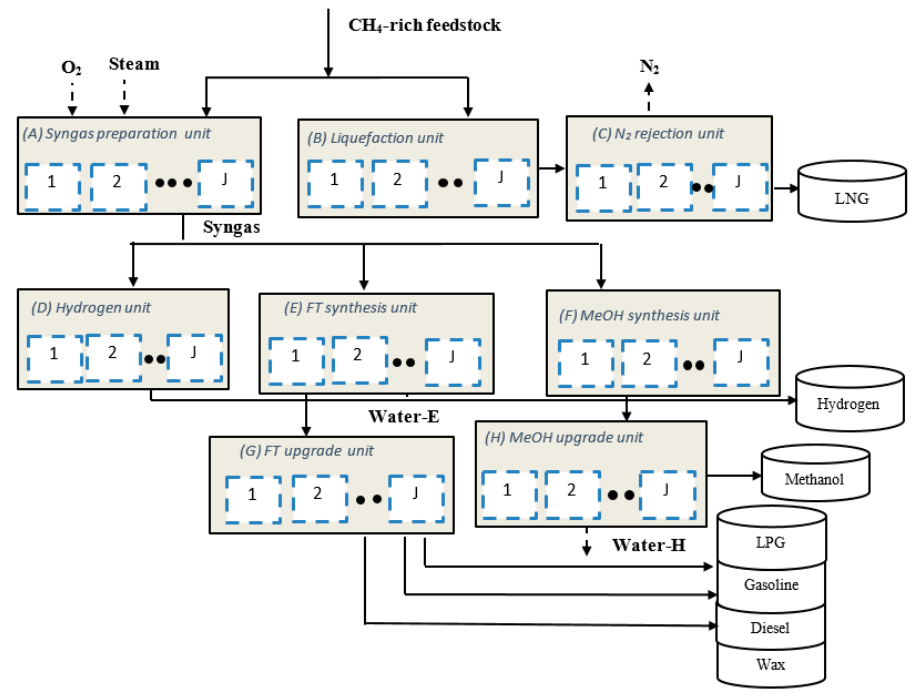
Figure 1. Superstructure representation for the considered natural gas downstream utilization network.